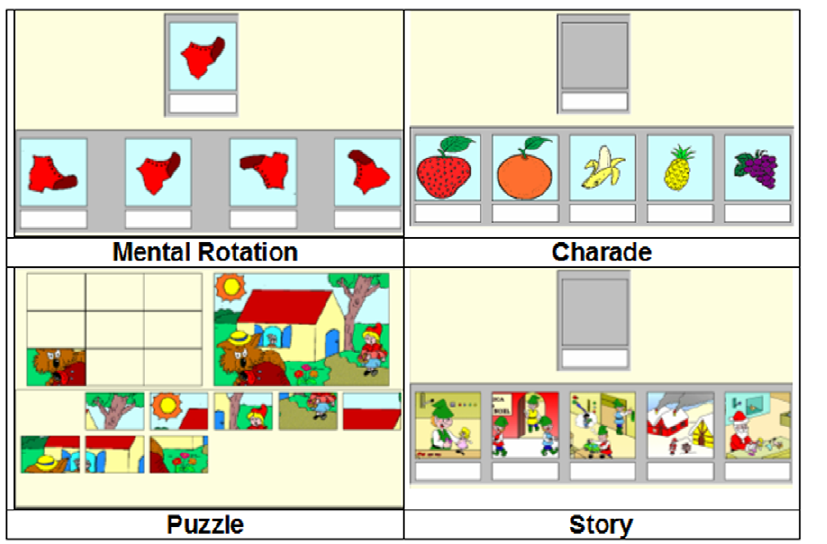
Figure 6. The games. The game rules are: a) Mental rotation ( Mr ): an object in a given spatial orientation is provided as a model to be matched to one out of four possible spatial orientations of the same object. Each game session involved 10 decision-making trials designed to explore visual reasoning; b) Puzzle solving ( Pz ): nine pieces of a scene, animal or object must be assembled over a nine-cell rectangle. The entire game includes three different pictures to be assembled. A warning signal indicates any piece misplacement. In this case, the subject had to remove the misplaced piece before trying another piece. Each game session involves at least 27 trials of decision-making designed to explore visual planning and reasoning; c) Charade solving ( Ch ): a three to four phrase description of a fruit or animal (e.g.; ‘‘My juice is delicious, my colour is my name; …’’) is provided 500 ms before different pictures are displayed for decision making. Mean soundtrack duration for all charades is around 4 seconds. Each game session involved 10 trials of decision-making designed to explore speech comprehension and semantic memory; d) Story understanding ( St ): a verbal description of scenes of a Christmas story is provided 500 ms before five Christmas scenes are visually displayed for decision-making. Mean soundtrack duration for all scene descriptions is 5 seconds. Each game session involved 10 trials of decision making designed to explore speech comprehension and episodic memory.